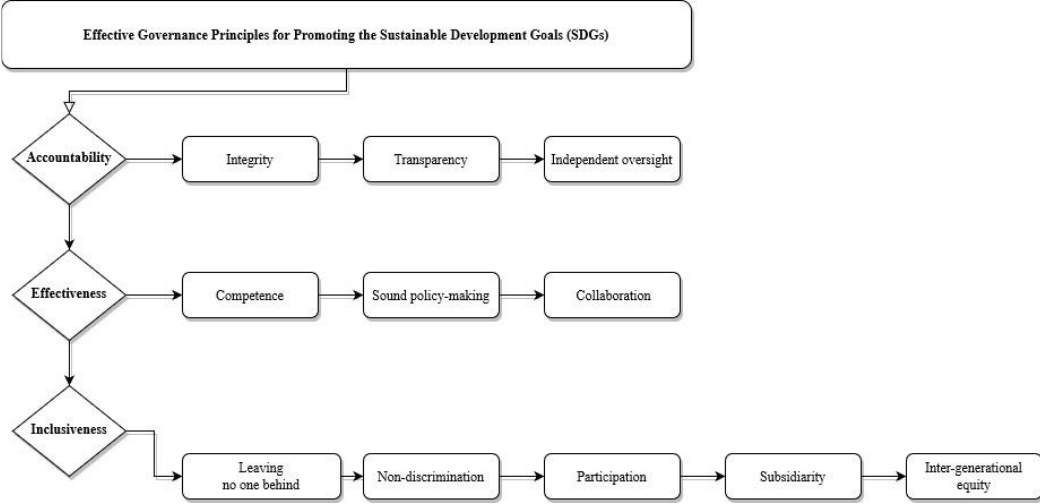
Figure 1 : SDGs Effective Governance Principles; Source: Author